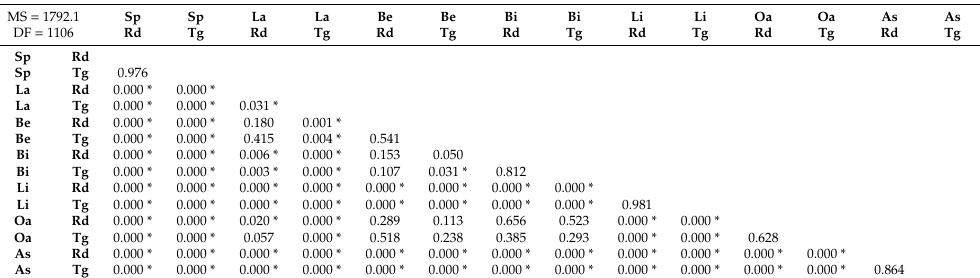
Table A3. Duncan´s Multiple Range Test for Density.